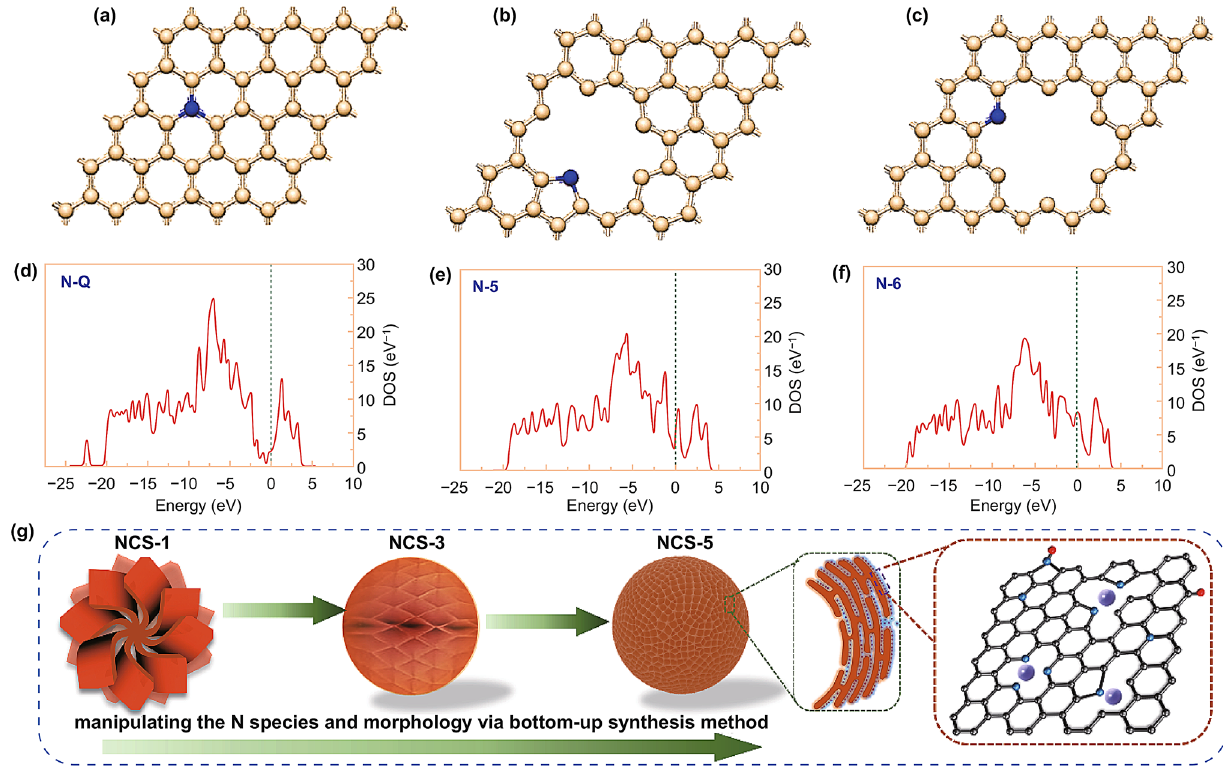
Fig. 6 Theoretical simulations of the formation mechanism of N-doped structures. Top views of the configurations of ( a ) N-5, ( b ) N-6, and ( c ) N-Q. Corresponding projected density of states for ( d ) N-5, ( e ) N-6, and ( f ) N-Q. ( g ) Schematic illustration of the hierarchical structure evolu- tion of